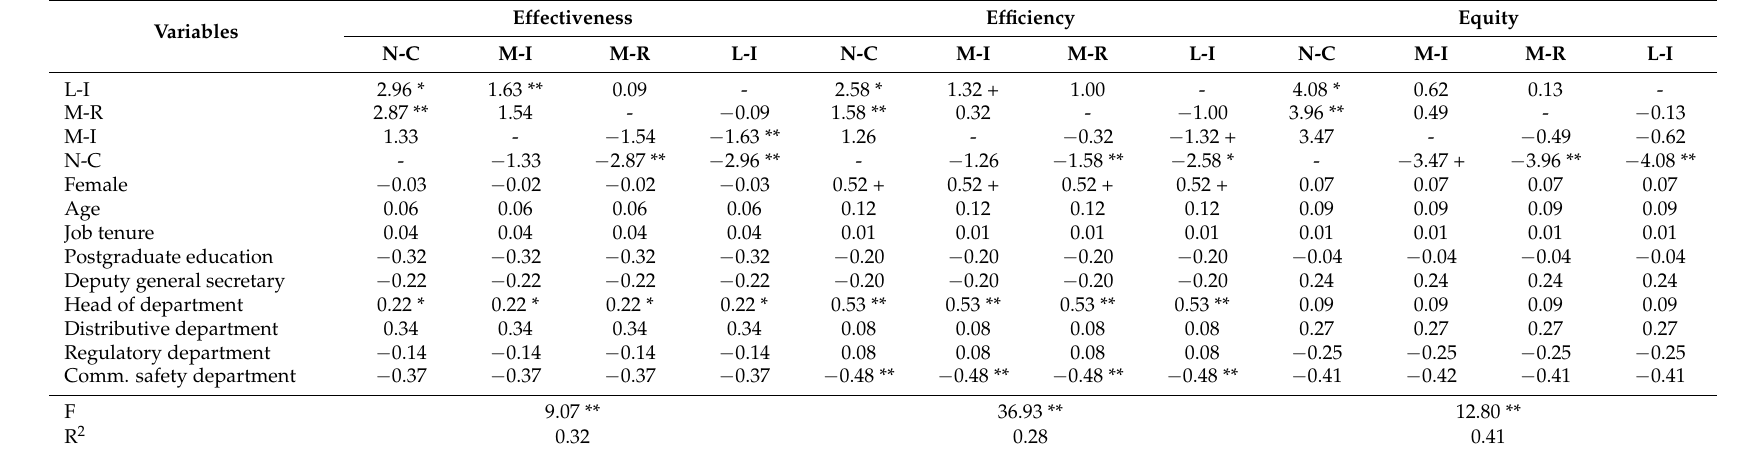
Table 4. Strategy implementation style and perceived